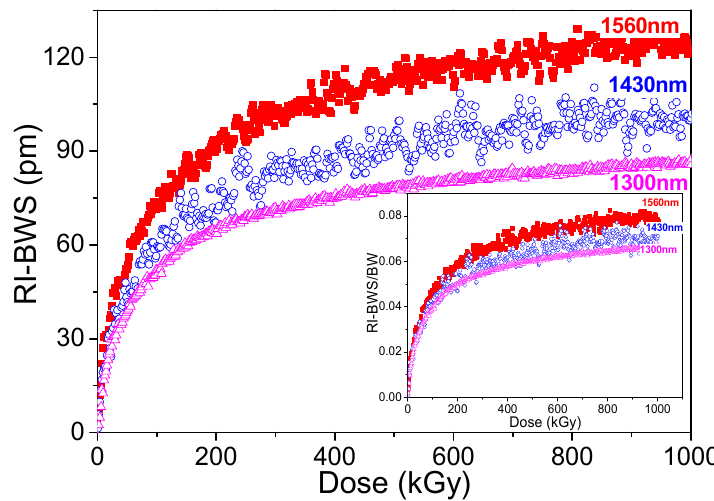
Figure 8. BWS induced by X-rays at RT up to 1 MGy (dose rate of 50 Gy/s) on three similar gratings (having the same ∆ n mod of about 2 × 10 − 4 ) written with a CW UV laser (at 244 nm) in H 2 -loaded Corning SMF28 at different Bragg wavelengths. In the inset, RI-BWS normalized with respect to the initial Bragg wavelength. Data extracted from [49].